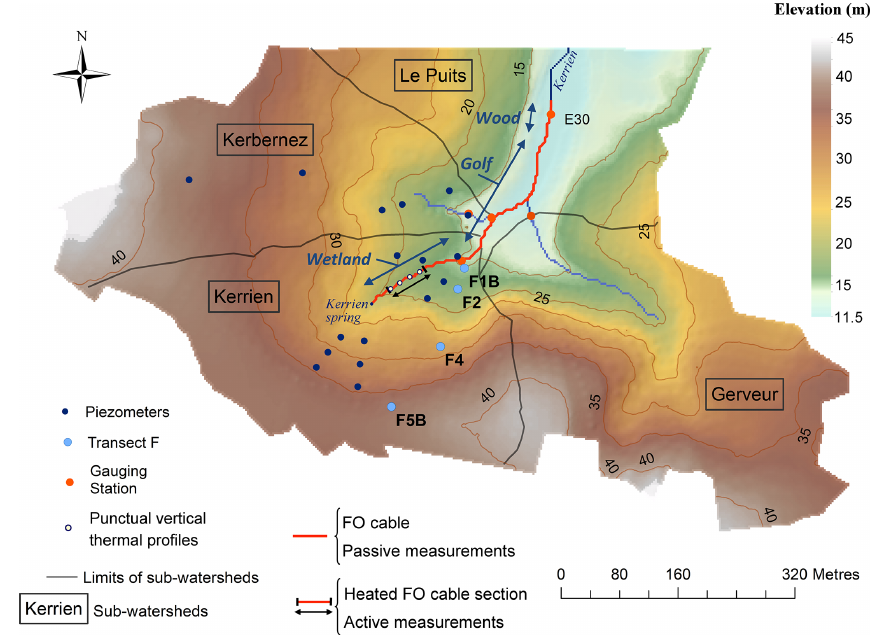
Figure 1. Description of the watershed with the location of piezometers, gauging station, and fibre optic cables.